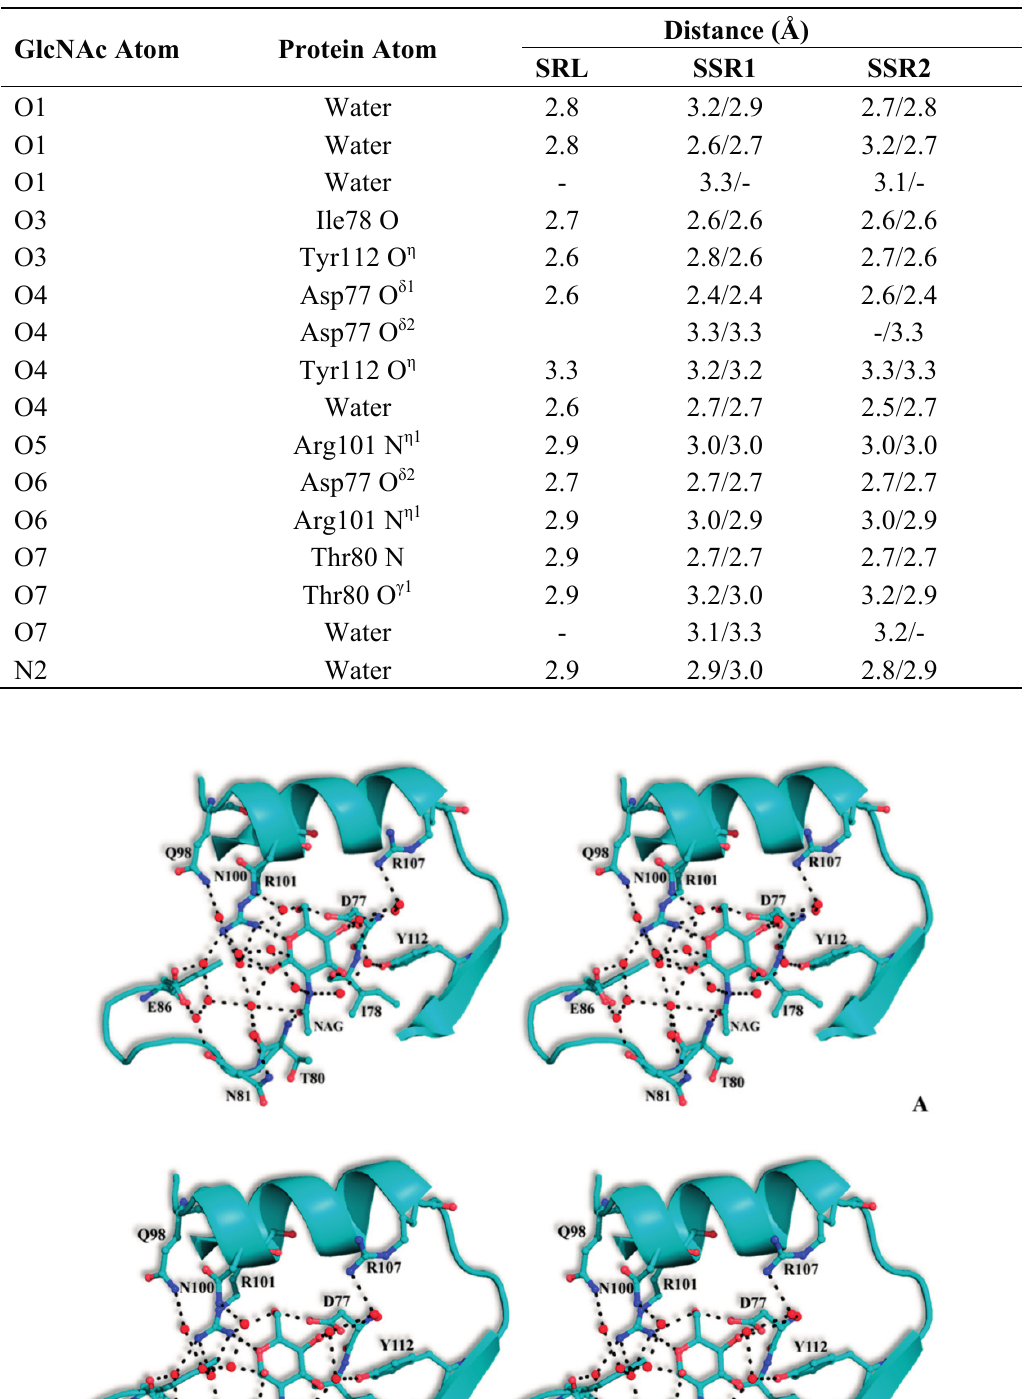
Table 6. Potential hydrogen bonds of GlcNAc with SRL (data from [7]) and SRL variants in the crystal. In the SSR1 and SSR2 complexes the distance for the α and β conformations of GlcNAc is